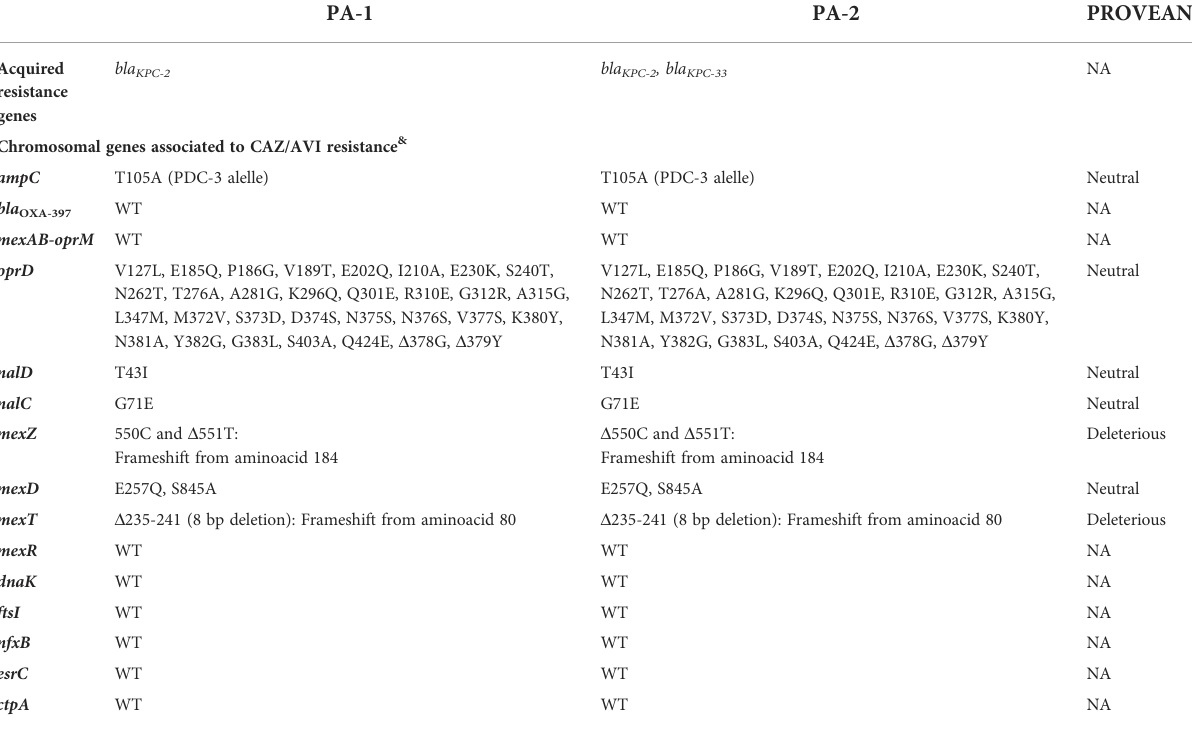
TABLE 2 Sequence analysis of PA-1 and PA-2 acquired resistance genes and chromosomal genes associated with CAZ/AVI resistance compared to PAO-1 control